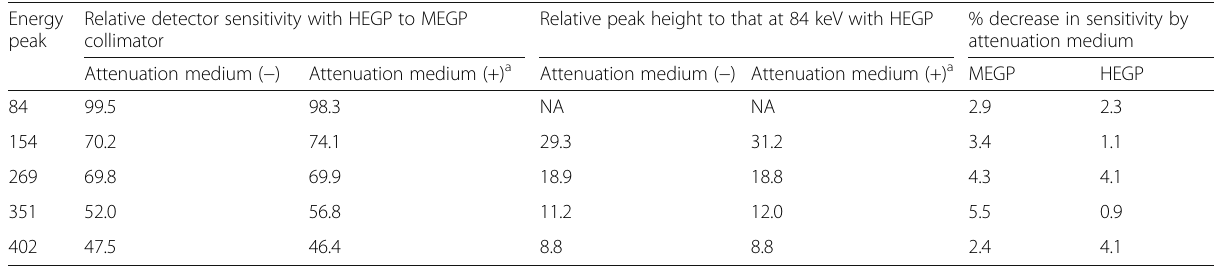
Table 1 Energy spectra of a Ra-223 vial with MEGP and HEGP Energy Relative detector sensitivity with HEGP to MEGP peak